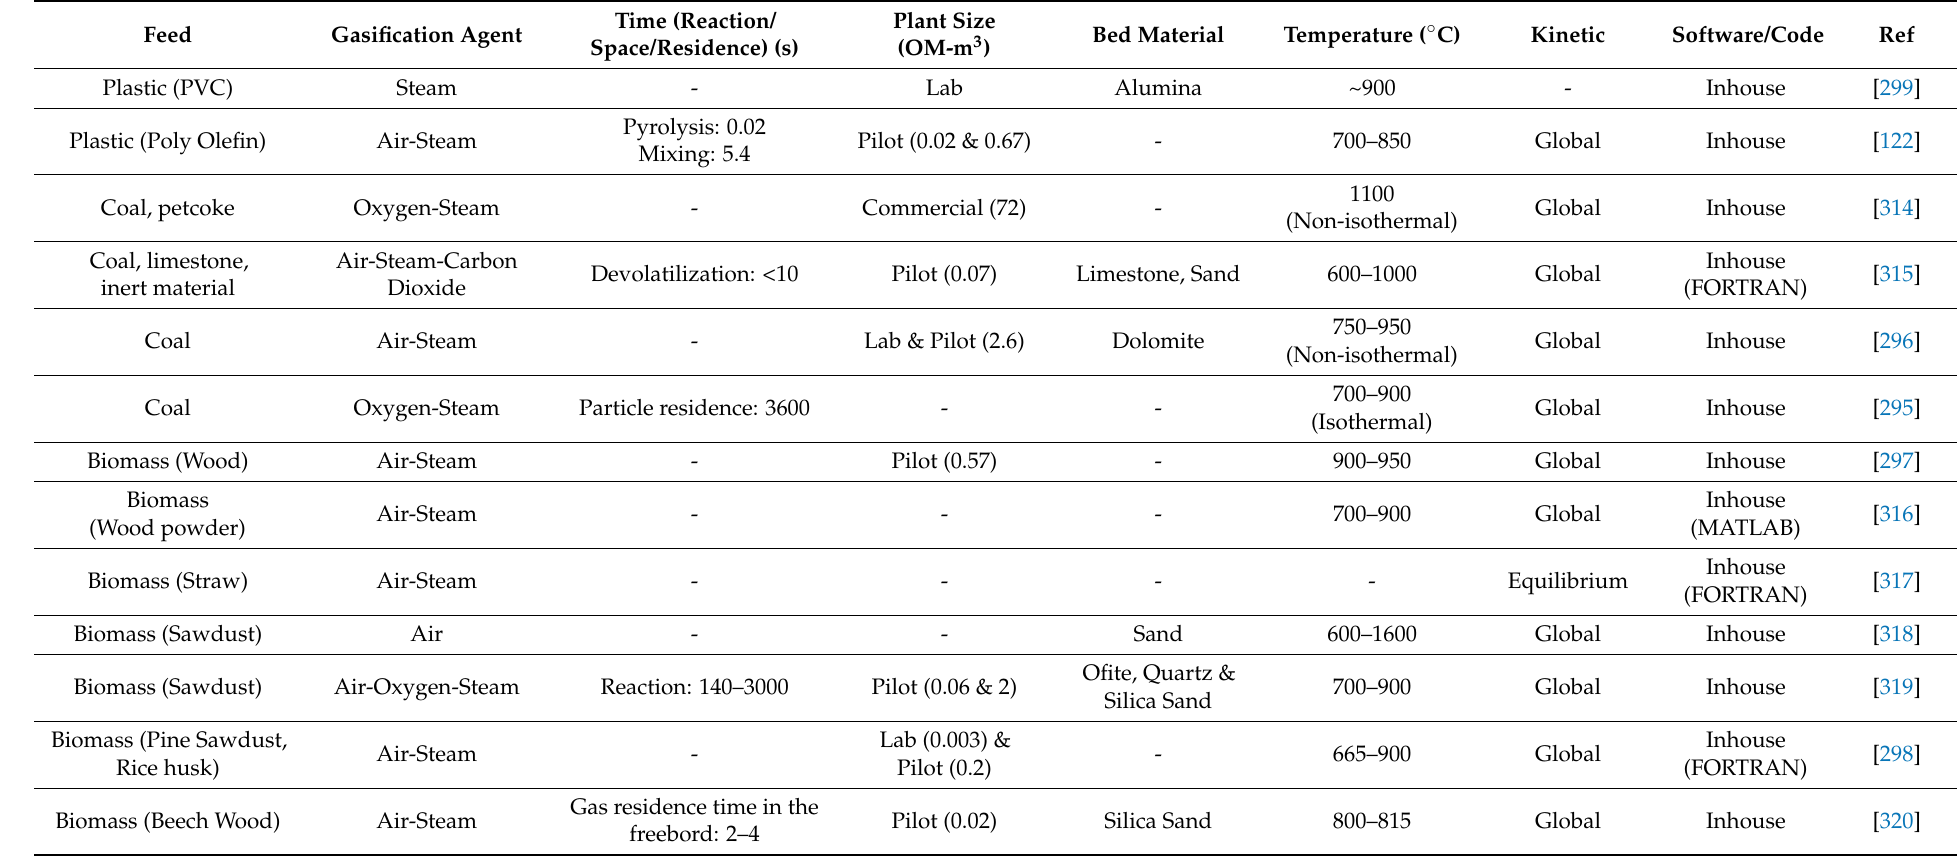
Table 5. Overview of fluidized bed gasification studies using two-phase modeling in engineering approach for different